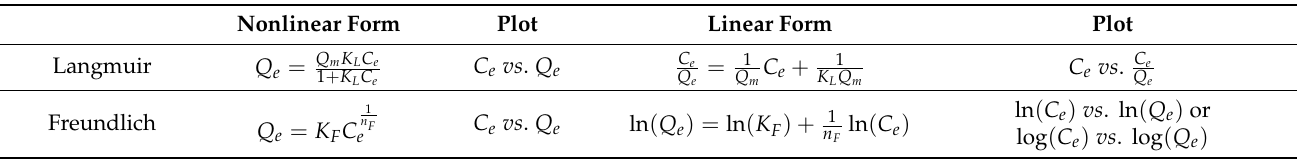
Table 1. Langmuir and Freundlich adsorption isotherms. Nonlinear Form Plot Linear Form Plot